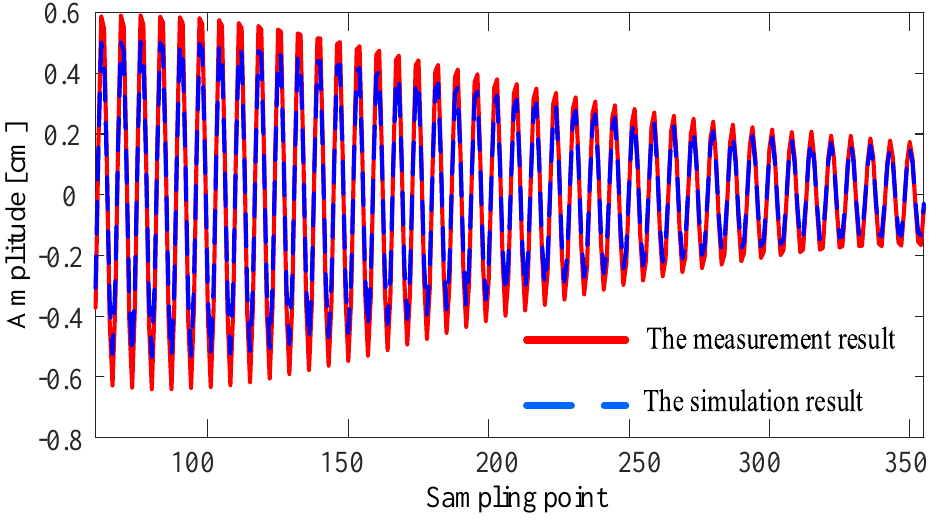
Figure 15. Comparison of the measurement data and simulation data.